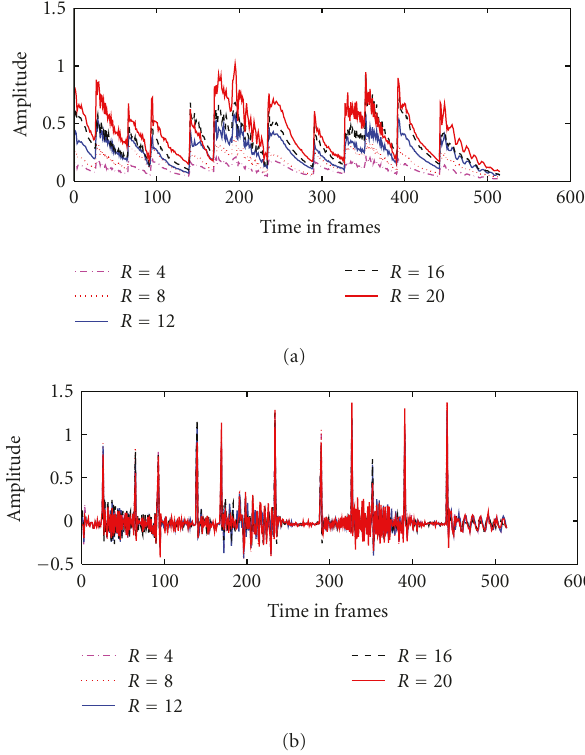
Figure 8: Detection performance in terms of h o ( k ) (upper subplot) ( k ) (below subplot) remains relatively constant despite the and h o r variable rank R